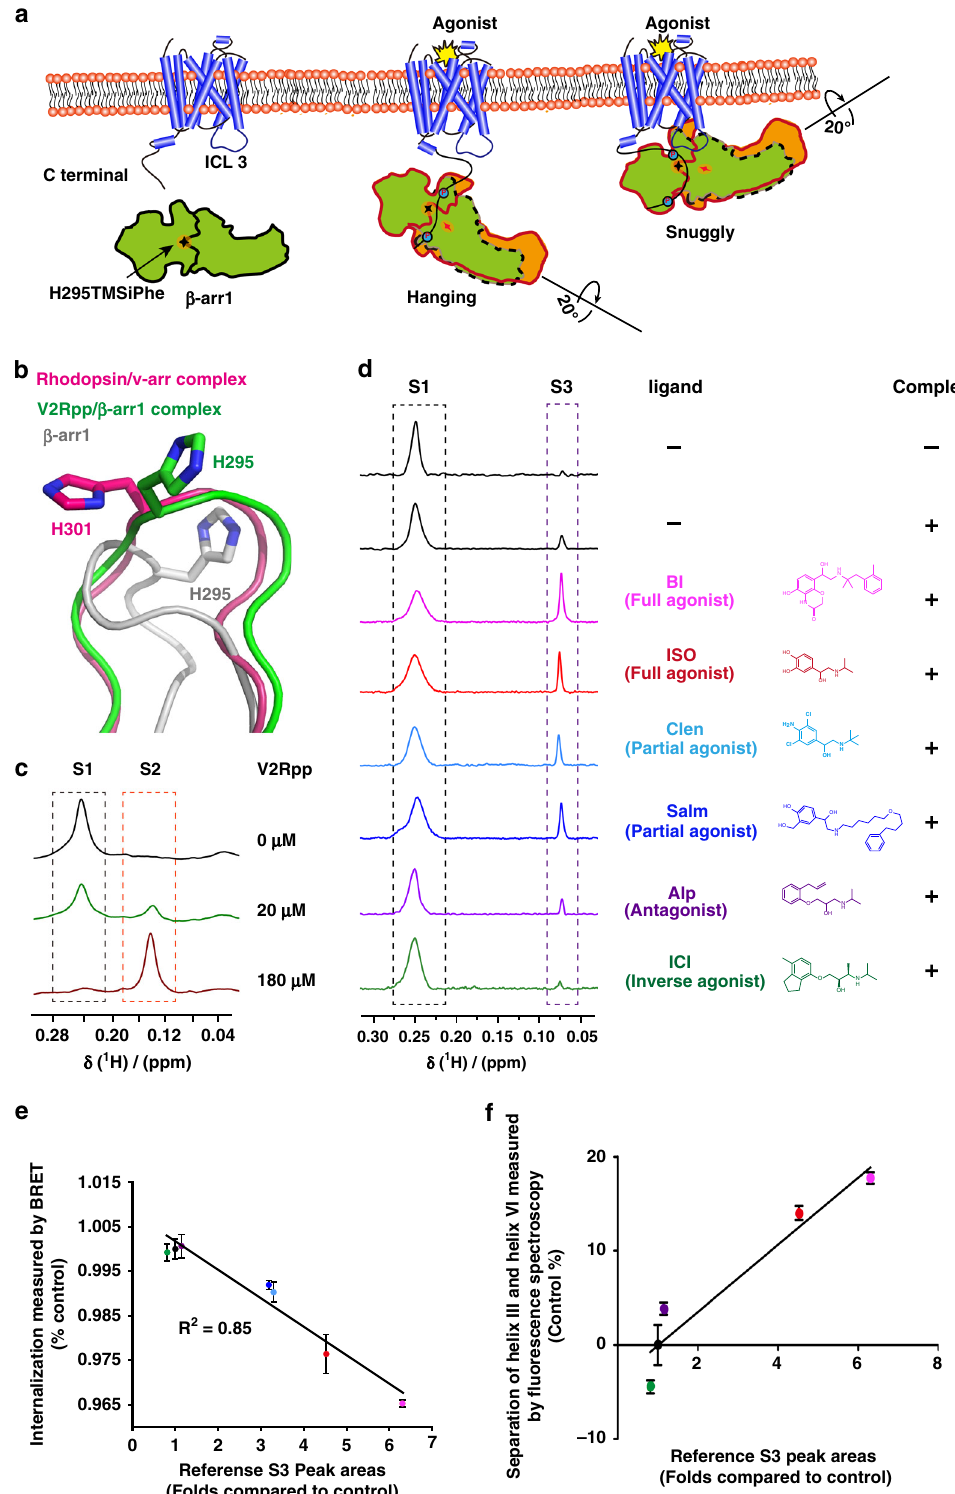
Supplementary Fig. 23). Overall, the DeSipher spectrum of β -arr1 H295TMSiPhe indicated that the conformational changes in the polar core of the arrestin in response to ligand properties are associated with the abilities of these ligands to promote receptor internalization in the presence of the same receptor- phosphorylation barcode (Fig. 4e, f and